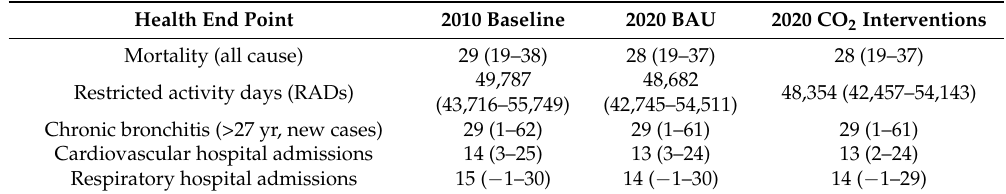
Table 6. The health impacts of PM 2.5 exposure in population of Kuopio urban area as number of cases. Central estimates with 95% confidence intervals in parentheses.